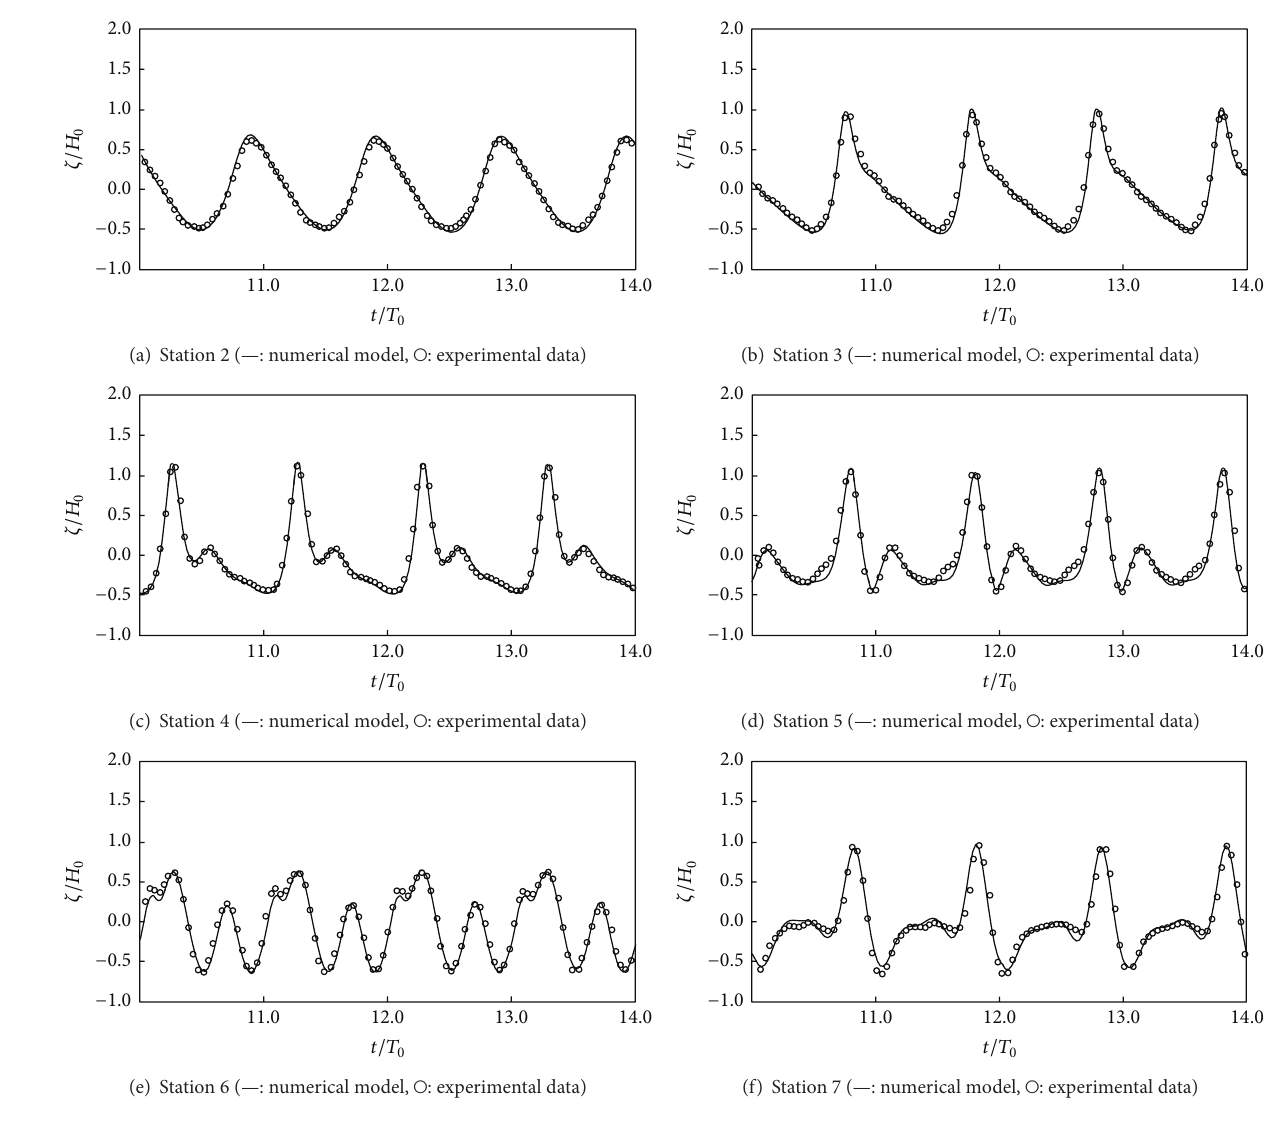
Figure 4: Water surface displacement obtained from the numerical model and experiments